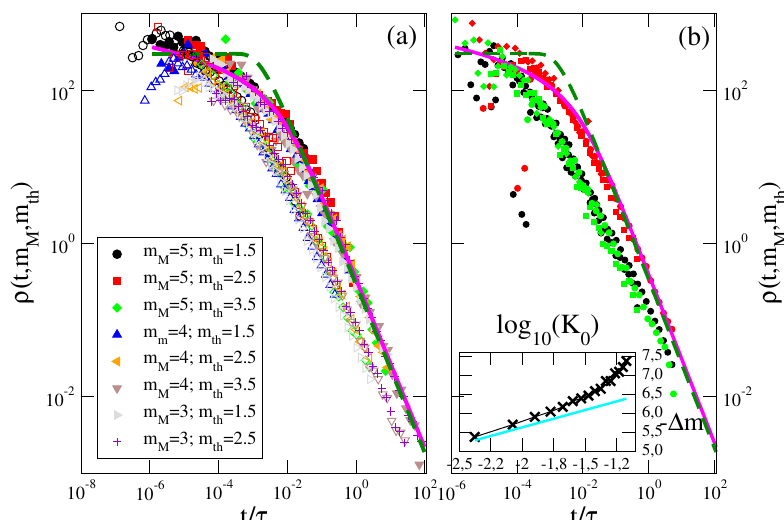
Figure 7. (Color online) ( a ) The same data in Figure 6 are plotted as function of t / τ , with τ = 10 d ( m M − m th ) proportional to c meas (Equation (8)) with d = 1, for different values of m M and m th . Filled (empty) colored symbols are used for data of Region 1 (Region 2). The magenta continuous line is the scaling function (cid:0) (cid:1) F ( x ) = A log 1 + Bx − p with A = 0.35, B = 70 and p = 1.1, whereas the dashed green line is the scaling function F ( x ) = A ( x / B + 1 ) − p with A = 300, B = 7 and p = 1.1. ( b ) The aftershock density ρ ( t , m M , m th ) in the ETASI1 catalog, with a blind time ∆ t = 1 min, is plotted as a function of t / τ . Different values of m M and m th are plotted with different symbols: stars for m M − m th = 2.5, crosses for m M − m th = 1.5 and plus for m M − m th = 0.5. Different colors correspond to different values of K 0 and of the average background rate r B : K 0 = 0.035 and r B = 4.38 days − 1 (black), K 0 = 0.035 and r B = 8.3 days − 1 (green) and K 0 = 0.068 and r B = 4.38 days − 1 (red). Magenta continuous and green dashed lines are the same scaling functions F ( x ) plotted in ( a ). (Inset) The value of ∆ m (Equation (8)) as function of log 10 ( K o ) for the ETASI model with a blind time ∆ t = 1 min (black crosses). The cyan line is the theoretical prediction (Equation (18)). From